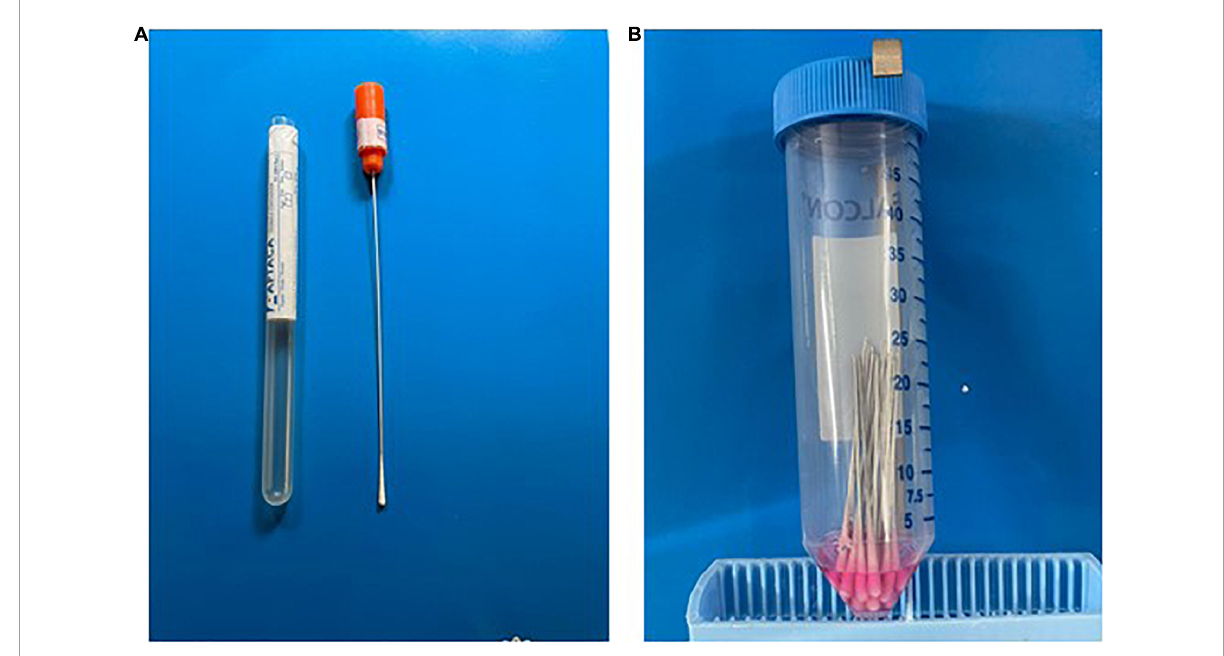
FIGURE1 Executive steps of sampling and testing. (A) Individual test tube. (B) Pool of individual swabs in a 50 mL tube containing 2 mL of DMEM.